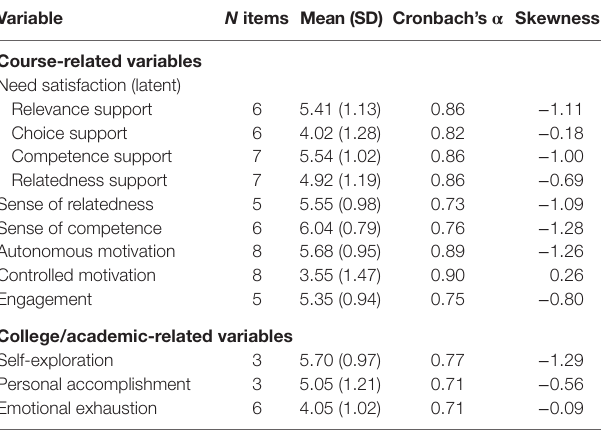
Table 1 | Descriptive statistics of study variables.